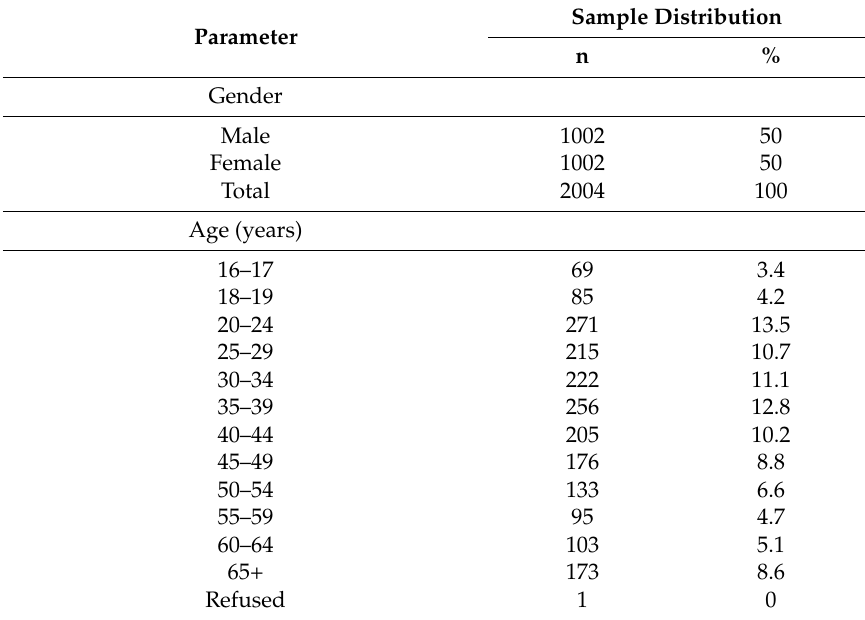
Table A1. Demographic variables of the sample group ( n =